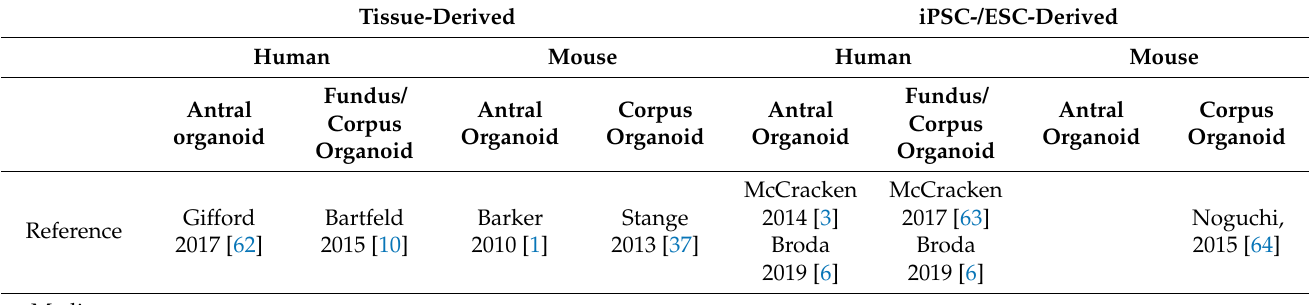
Table 2. Characterization of mouse and human gastric organoids. Each culture component in the organoid medium is compared and listed. Tissue-derived and induced pluripotent stem cell (iPSC)- and embryonic stem cell (ESC)-derived organoids are compared in terms of the precise components of their culture media. Key: APT, inhibitor of the γ -secretase complex; DKK1, Dickkopf1; FBS, fetal bovine serum; HEPES, 4-(2-hydroxyethyl)-1-piperazineethanesulfonic acid; NEAA, nonessential amino acids; SHH, Sonic